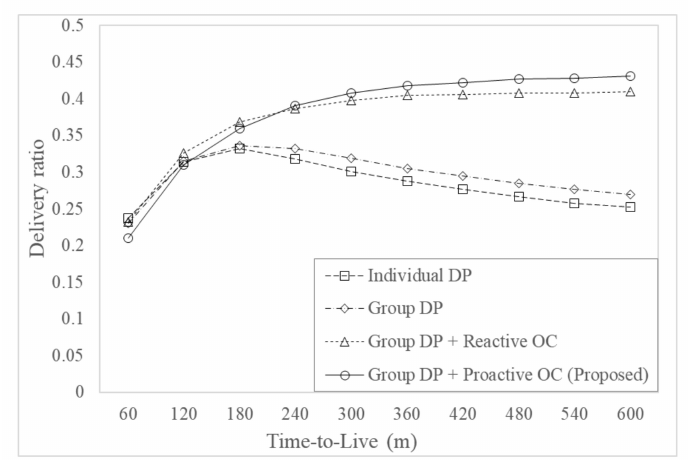
Figure 11. Delivery ratio for varying TTL.